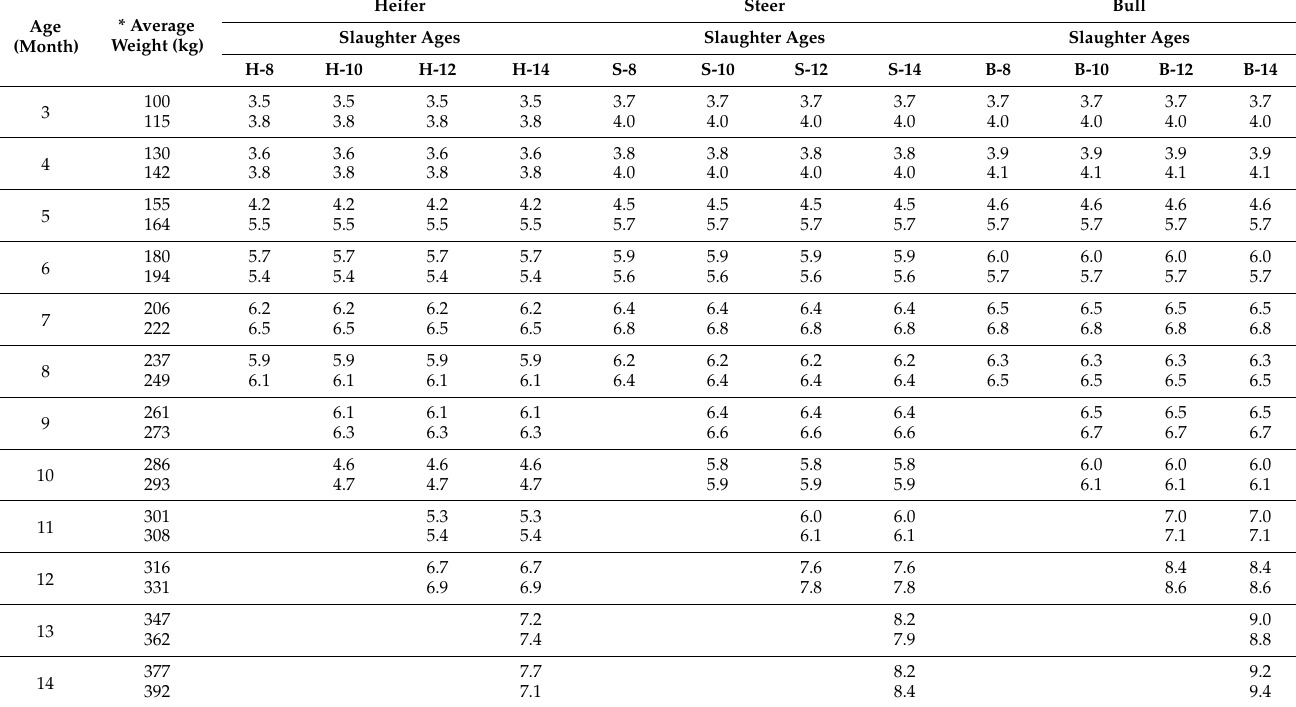
Table 1. Age, weight and daily per head feed demand for various classes of young beef cattle (kg DM/head/day). Age